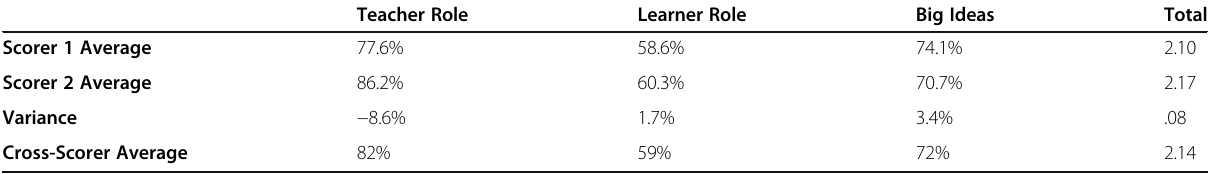
Table 1 Interrater Reliability for Vignette Scoring